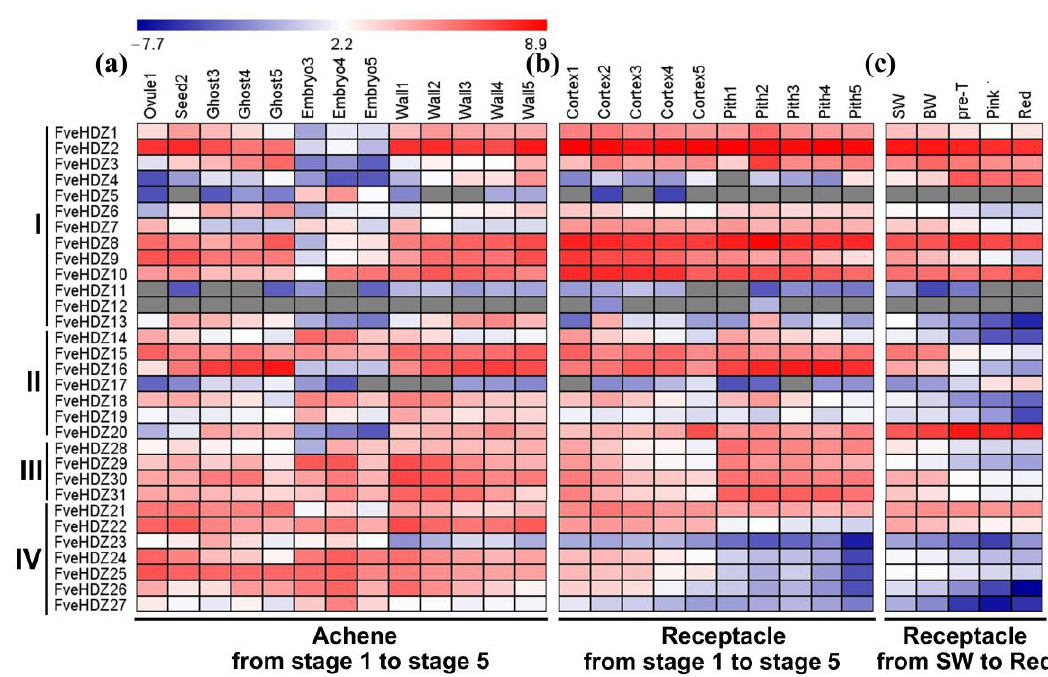
Figure 3. Expression patterns of FveHDZs in achene development ( a ) and receptacle development ( b ) and ripening ( c ). ( a , b ) Achenes included the ovule, seed, embryo, ghost, and wall tissues, and receptacles included the cortex and pith tissues. Numbers after the tissues indicated different fruit development stages. Data from Kang et al. [43] and Hollender et al. [44]. ( c ) SW, small white; BW, big white; and Pre-T, pre-turning. Data from Gu et al. [45]. The heat map showed log2 “relative RPKM values” of individual FveHDZ genes. Gray boxes indicated undetectable expression of the genes.